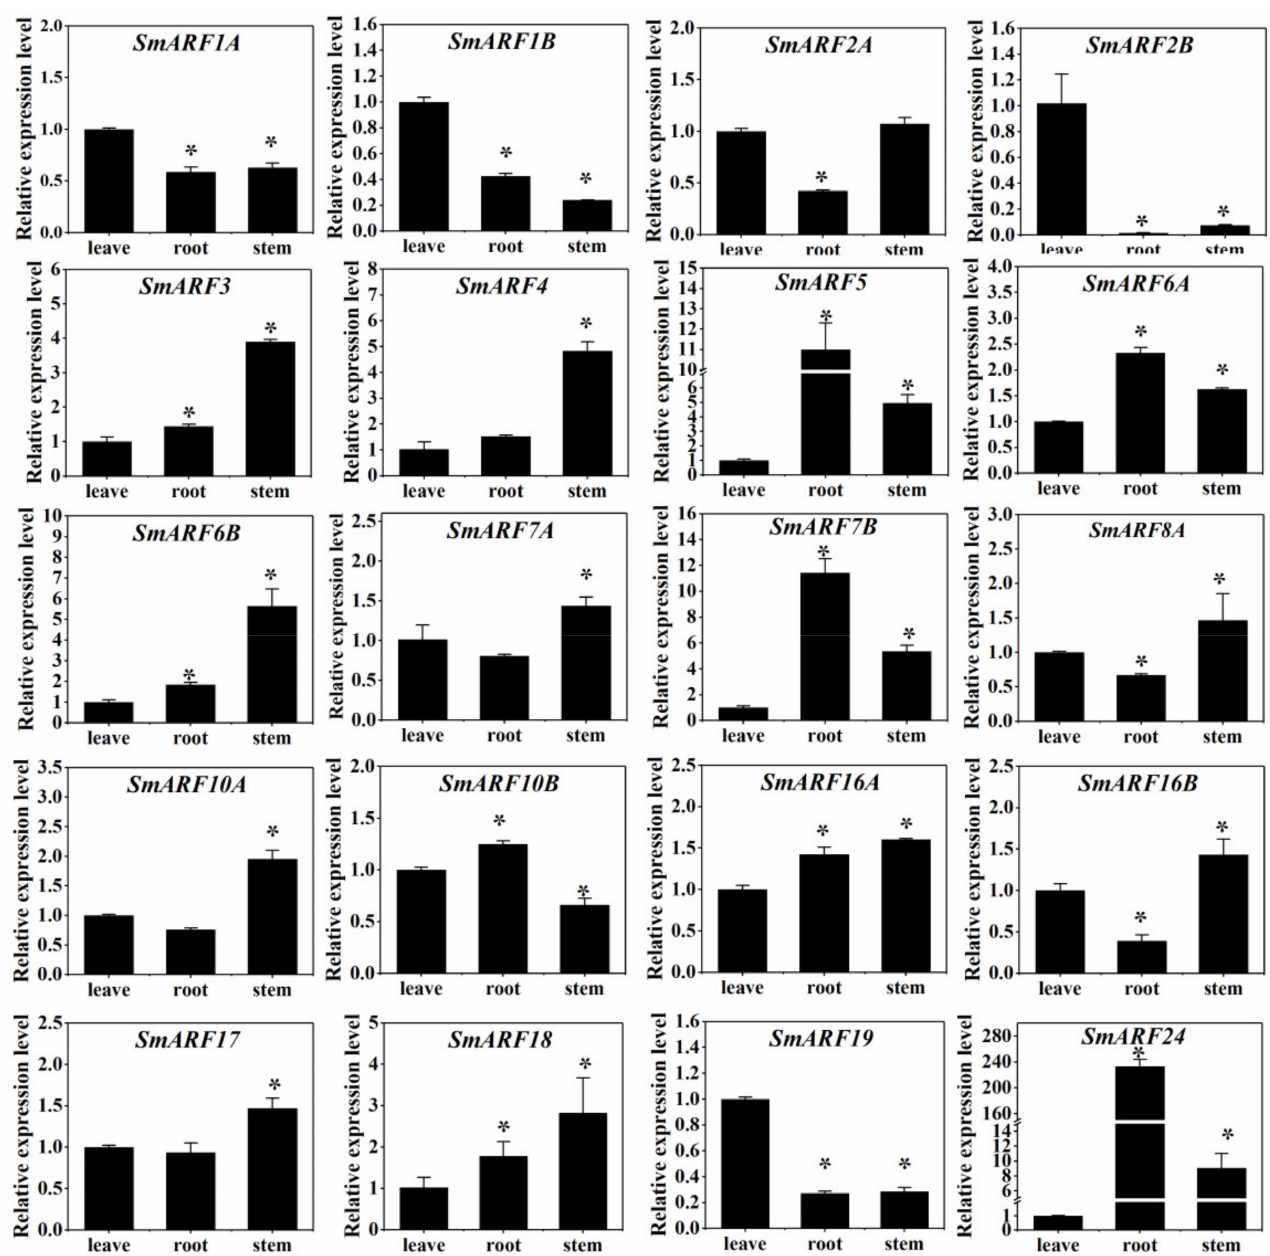
Figure 6. The expression profiles of SmARF genes in the leaves, roots, and stems of 3–week–old eggplants. The relative expression level was calculated using the method of 2 −(cid:52)(cid:52) Ct . The relative mRNA levels of the leaves were used for the reference. The values are means ± SD ( n = 3). * represents significance at p < 0.05 comparing with